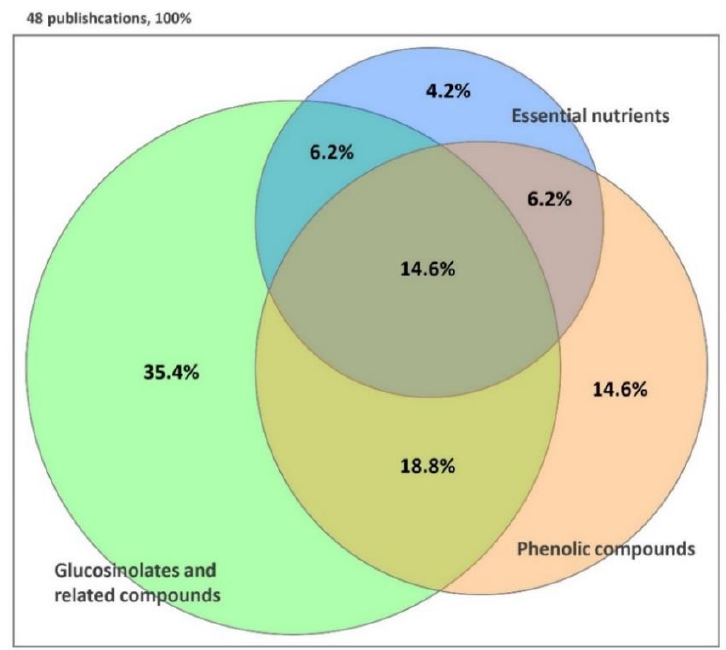
Figure 2. Summary of the bioactive compounds analyzed in the last ten years of broccoli sprouts and microgreens.